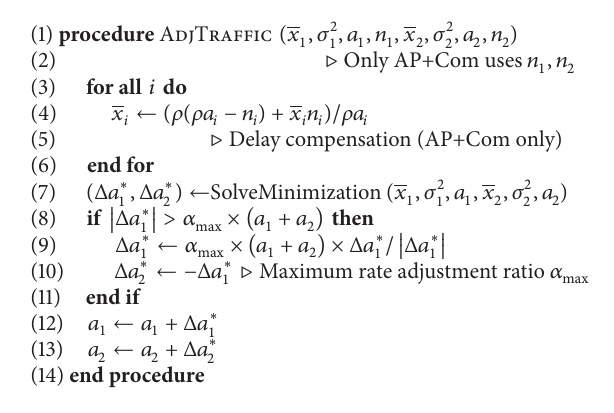
Algorithm 1: AP-based traffic distribution.